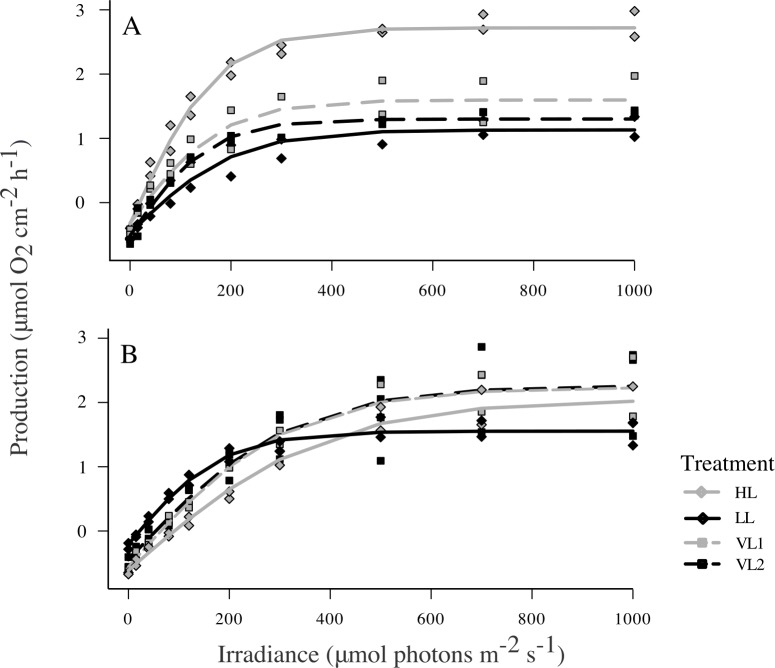
Photosynthesis-irradiance curves describing the contrasting photosynthetic features of the study species.Mean light-dependent oxygen production or consumption (μmol O2 cm-2 h-1) for Pachyseris speciosa (A) and Acropora millepora (B) at the end of the 20-day experiment in the high DLI (HL, solid grey), low DLI (LL, solid black), and variable DLI (VL1, dashed light gray, and VL2, dashed dark gray) treatments. N = 2–3 colonies/treatment/species.